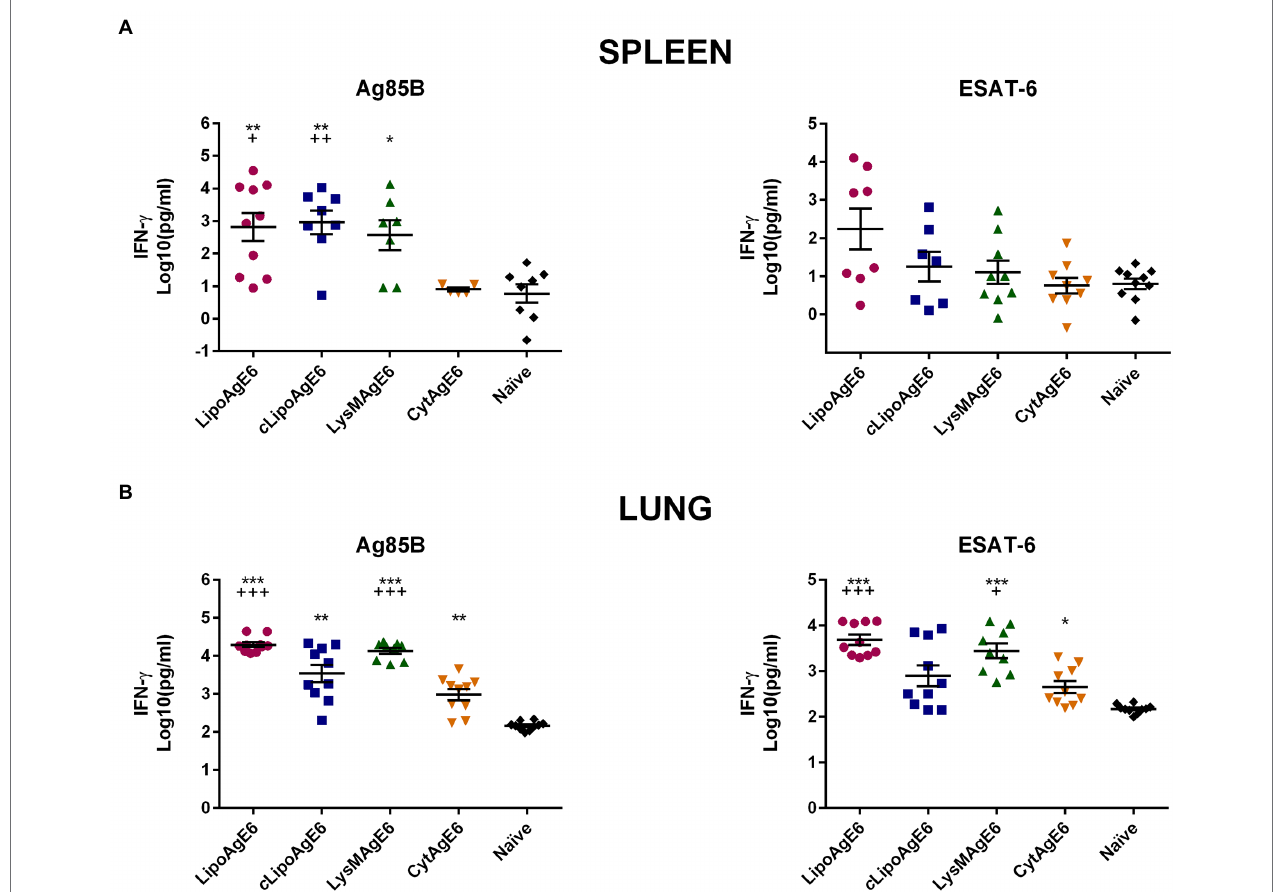
FIGURE 7 | The concentration of secreted IFN- γ in supernatants of splenocytes and total lung cells (TLC) induced by the recall antigens Ag85B or ESAT-6. Splenocytes (A) and TLC (B) from immunized mice were stimulated with Ag85B or ESAT-6 for 5 days, after which the levels of secreted IFN- γ were quantified by ELISA. Results are presented as a mean ± SEM of samples ( n = 5–10). The data were Log10-transformed to meet the ANOVA assumptions. Statistically significant differences were determined using one-way ANOVA with Games-Howell post-hoc test. Significant differences between either of the candidates and naïve mice or CytAgE6 are marked with * and + respectively. * /+ p < 0.05, ** /++ p < 0.01 and *** /+++ p <